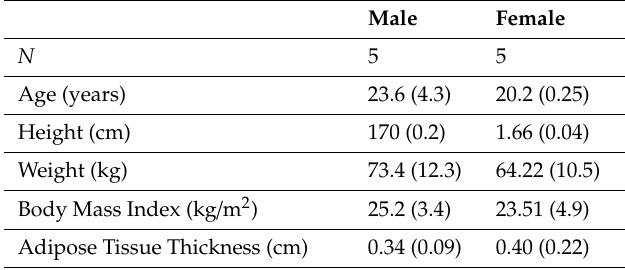
Table 1. Characteristics of study participants.